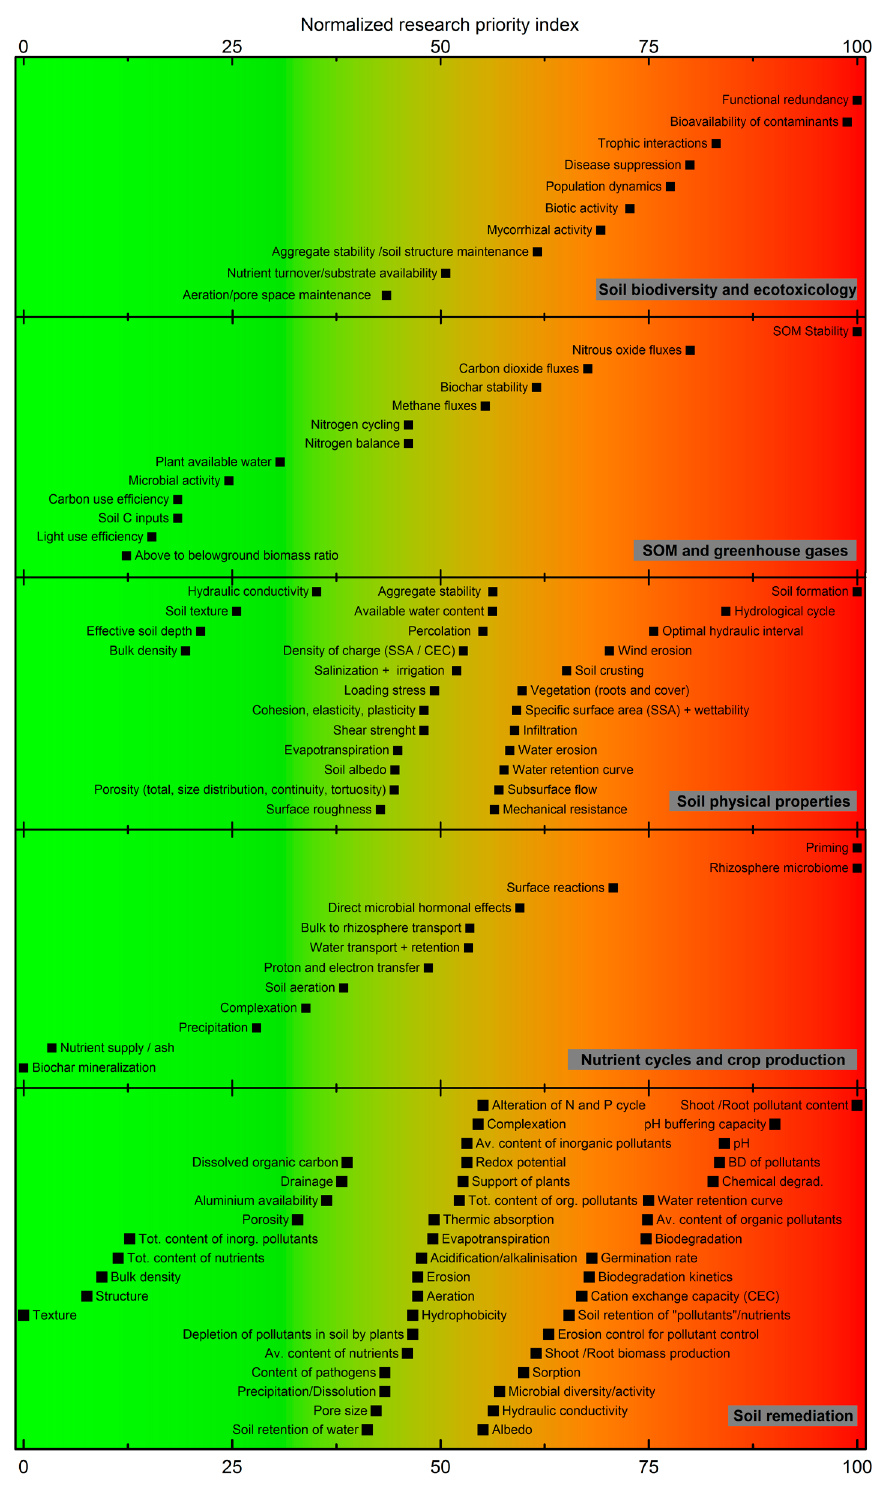
Fig. 2. Normalized research priority of the indicators as identified by the thematic groups. Higher values of RPI (and red background) refer to higher priorities. Abbreviations: Av. = Available; BD = Biodegradability; Org. = organic; Tot. =